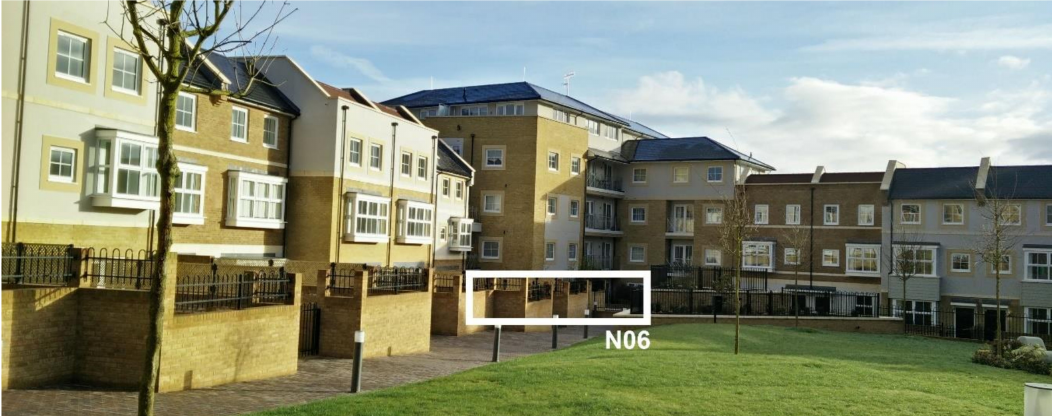
Figure 8. N06 highlighted in morning sun; extent of shading from